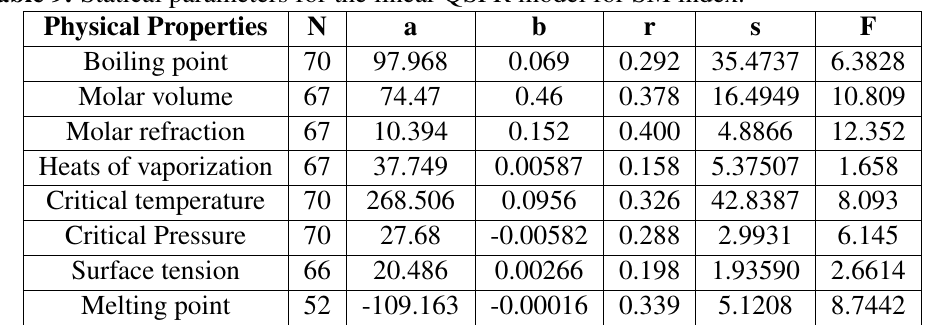
Table 9. Statical parameters for the linear QSPR model for SM